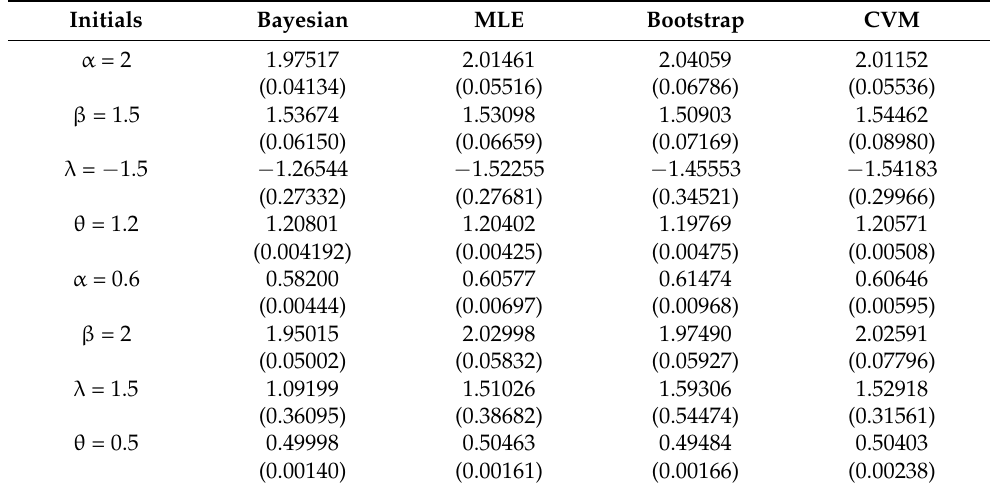
Table 3. The results of the AVs and their corresponding MSEs (in parentheses) for n = 50.